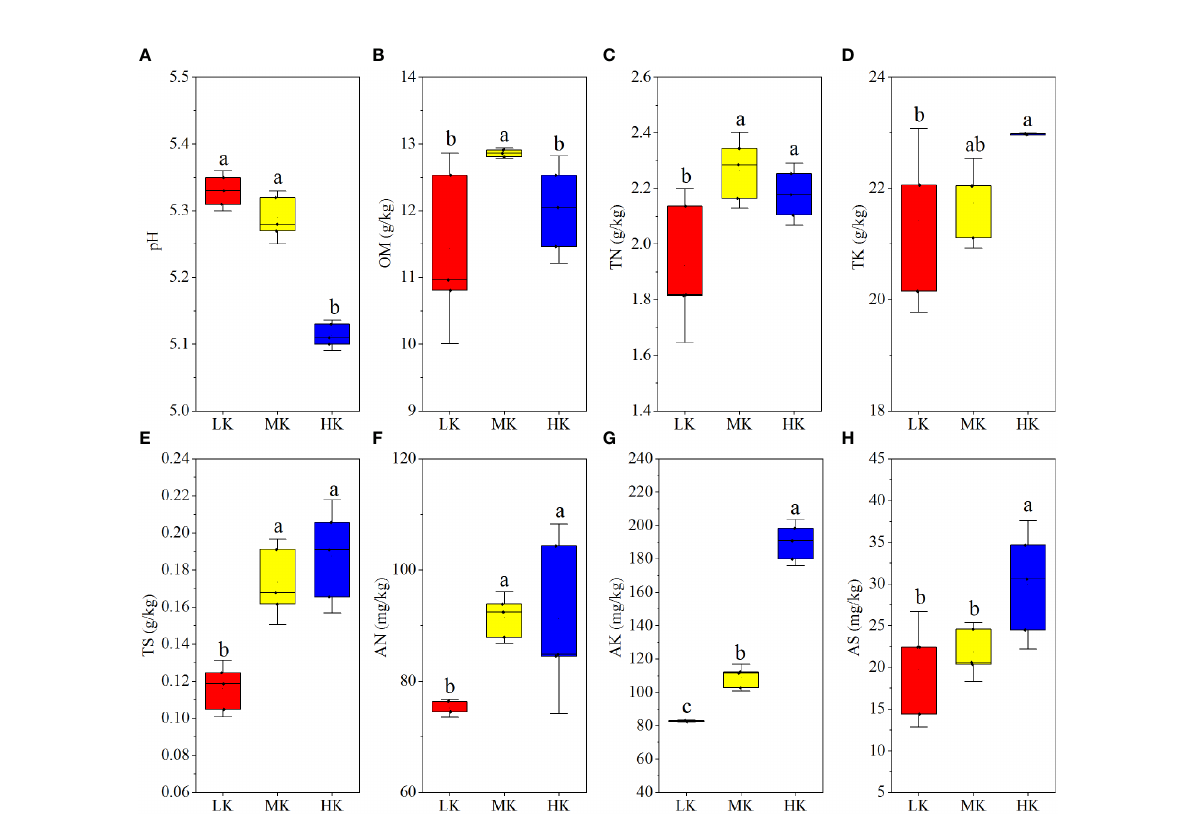
FIGURE 1 Soil physicochemical properties of plots with different fertilization regimes (A-H) . Different lowercase letters above the boxes indicate signi fi cant differences (P < 0.05) among the different treatments, as determined by ANOVA followed by the LSD test. LK, Low amount of K 2 SO 4 ; MK, Middle amount of K 2 SO 4 ; HK, High amount of K 2 SO 4 . OM, organic matter; TN, total nitrogen; TK, total potassium; TS, total sulfur; AN, available nitrogen; AK, available potassium; AS, available